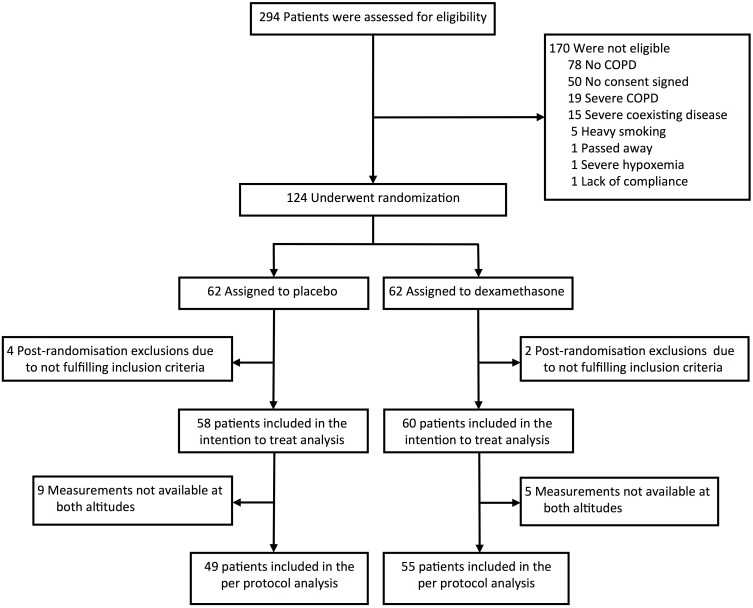
Study flowchart. 124 patients were randomized to dexamethasone respectively placebo. 6 patients were excluded after randomization leaving 118 patients in the intention to treat analysis. In 14 patients, successful balance tests were not available because of altitude-related adverse health effects (2) or incomplete test series (12). 104 patients were included into the per protocol analysis.